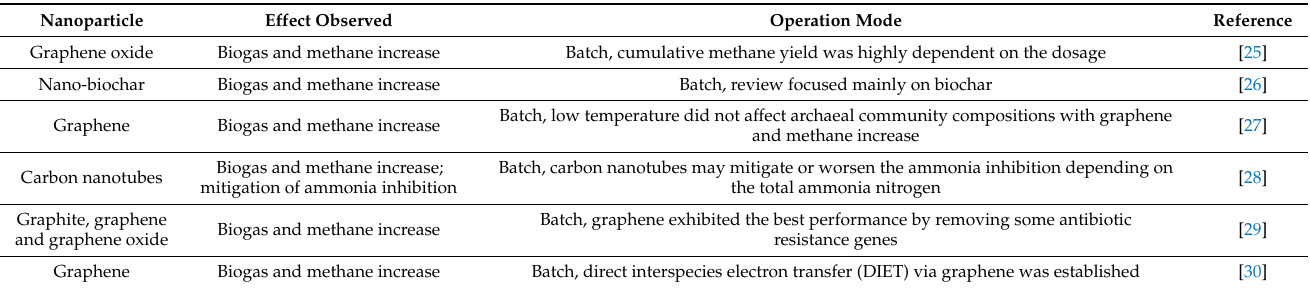
Table 2. Examples of studies using other nanomaterials and their effect on anaerobic